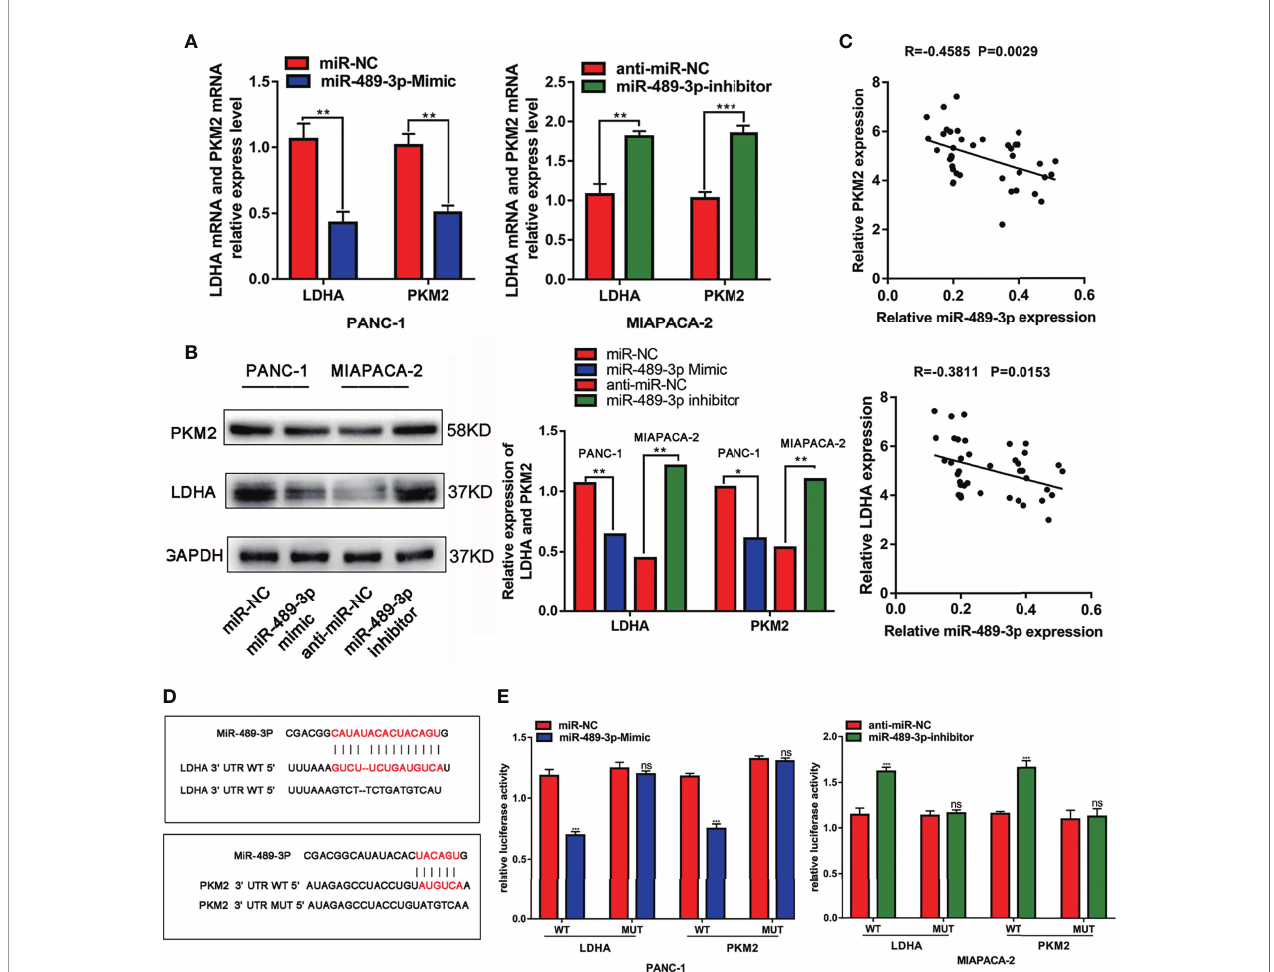
FIGURE 3 | MiR-489-3p targets LDHA and PKM2. (A, B) qRT-PCR and western blot assays showed relative expression of LDHA and PKM2 after PC cells transfected with miR-489-3p mimics and miR-489-3p inhibitor. (C) Spearman rank correlation analysis showed correlation between miR-489-3p and LDHA and PKM. (D) The predicted binding site of miR-489-3p in human LDHA and PKM gene 3 ’ UTR, and the corresponding sequence in the mutated type. (E) Luciferase reporter gene assay analysis of the relationship between miR-489-3p and LDHA and PKM. (*P < 0.05, **P < 0.01, ***P < 0.001, ns, no signi fi